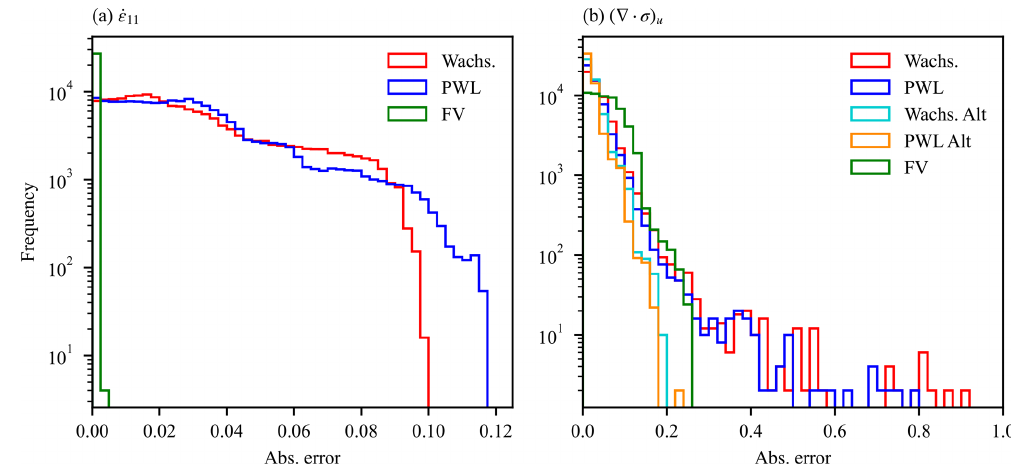
Figure 8. Frequency of grid cell error in the calculation of strain rate (a) and stress divergence (b) from an analytical velocity field for a spherical test case. The error is given as the absolute value of the difference between model and analytical fields. The results are plotted as histograms for the two variational schemes (using Wachspress and PWL basis functions and the alternative area formulation) and the finite-volume (FV)